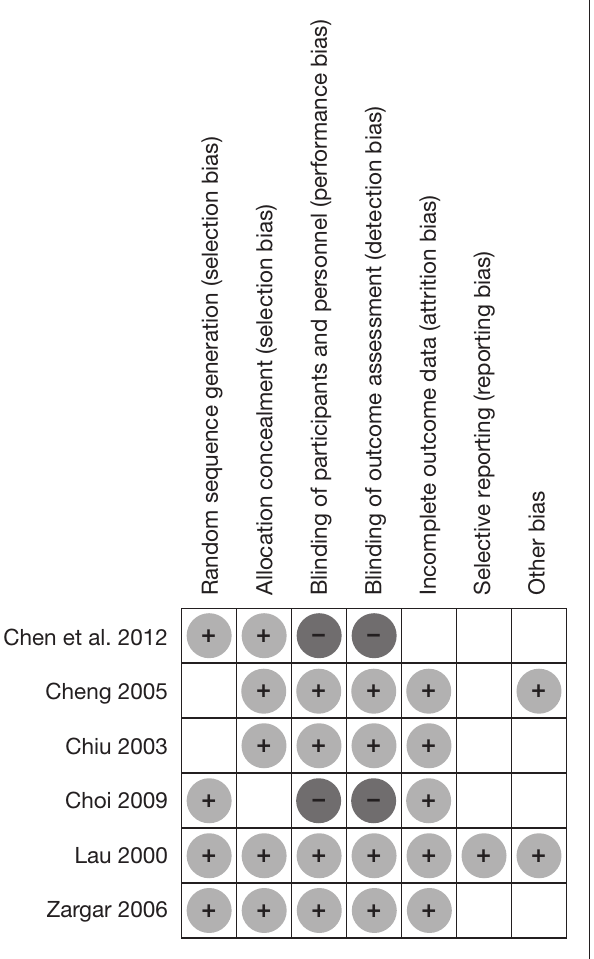
Figure 2) Risk of bias